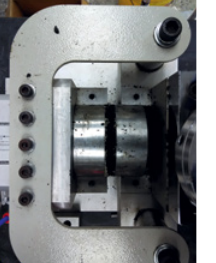
a) mould assembly